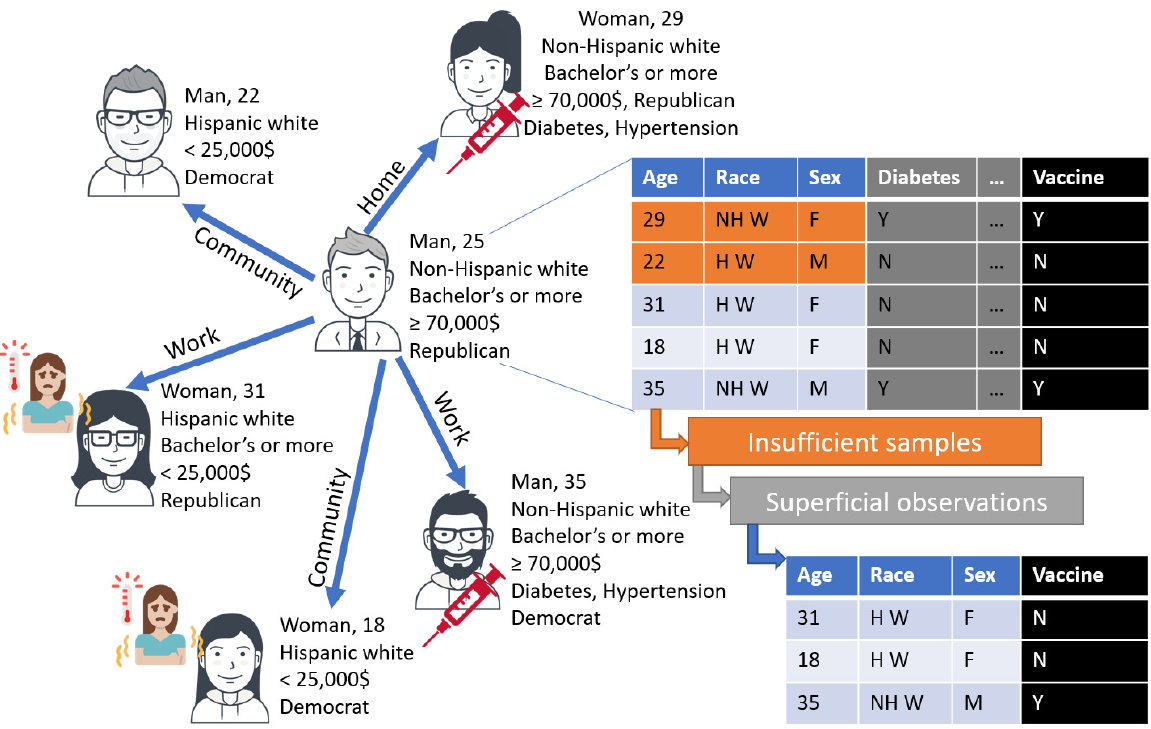
Figure 3. Each agent observes the vaccination decision and attributes of its peers. The initially perfect observations are altered by perceptual limitations and errors, thus producing an observation set with fewer peers and/or fewer attributes. Icons from User Insights and Coronavirus at icon-icons.com, CC Attribution license (CC BY 4.0).